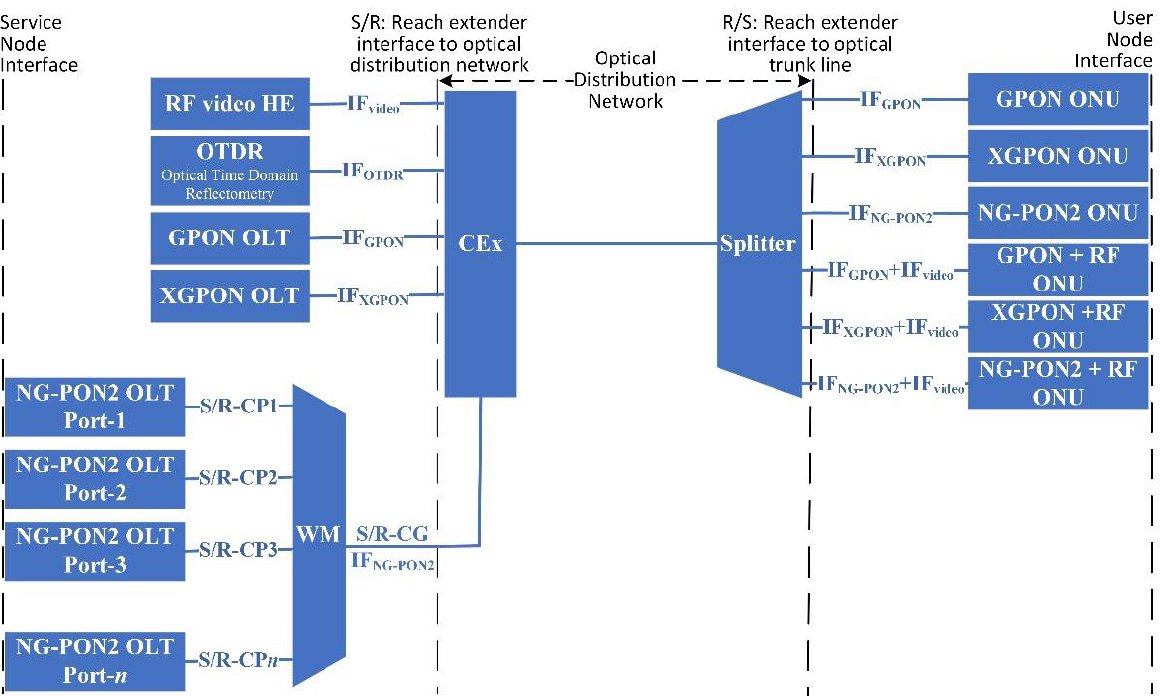
Figure 8. The NG-PON2 architecture as in [33]; IF (interface), CG (channel group), CP (channel pair), CEx (instance of co-existence element), HE (head end), WM (wavelength multiplexer).